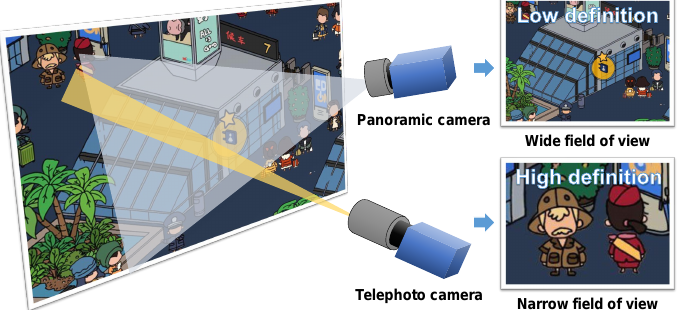
Figure 1. Contradiction between wide field of view and high-definition